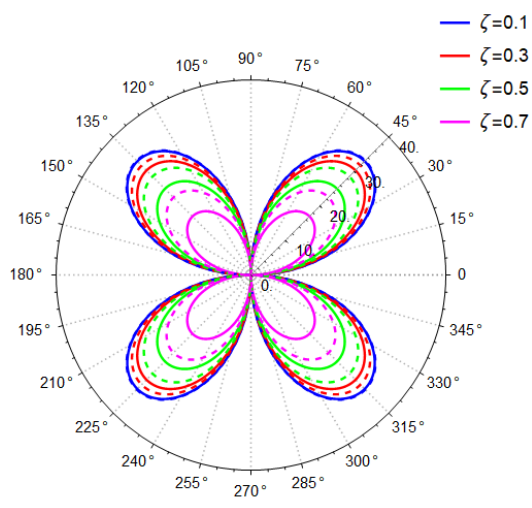
(solid lines) and 1 ] − 1 . The polar angle denotes the angle be- imp